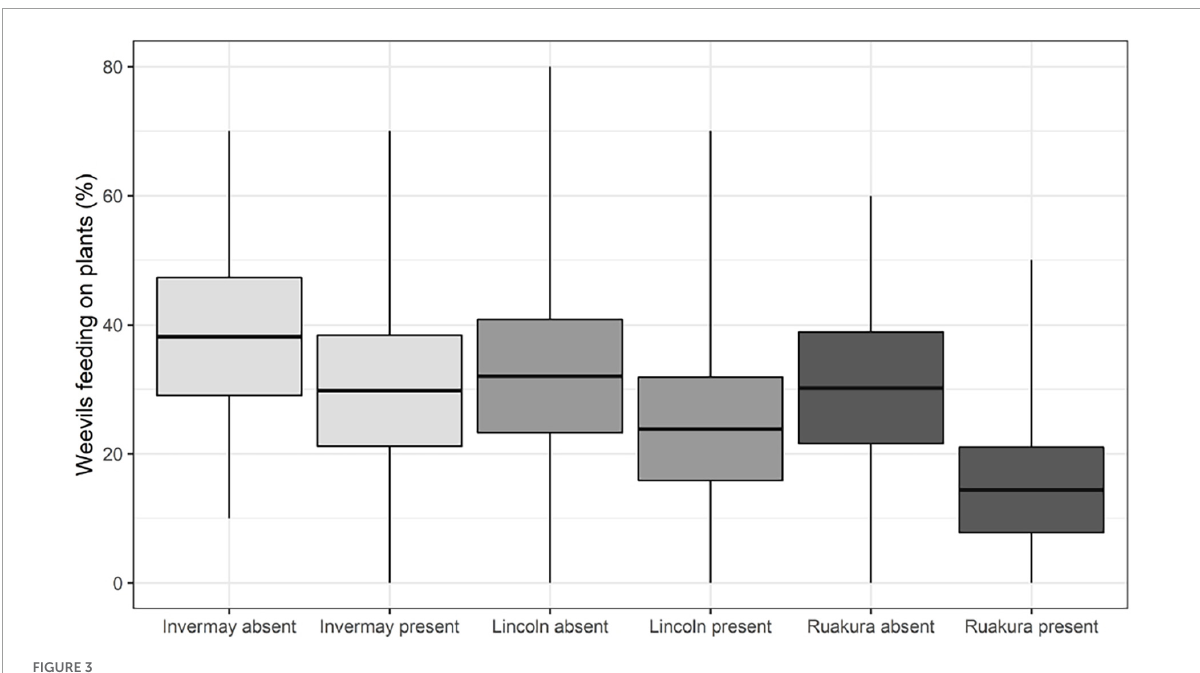
FIGURE3 The early season weevil experiment . Mean percentages of Listronotus bonariensis feeding in the absence or presence of Microctonus hyperodae . The weevils were collected from the Southern Region (Locality: Invermay), the Central Region (Locality: Lincoln), and the Northern Region (Locality: Ruakura) of New Zealand. Rectangles show the mean (central line) and 95% CL, and tails show the range.